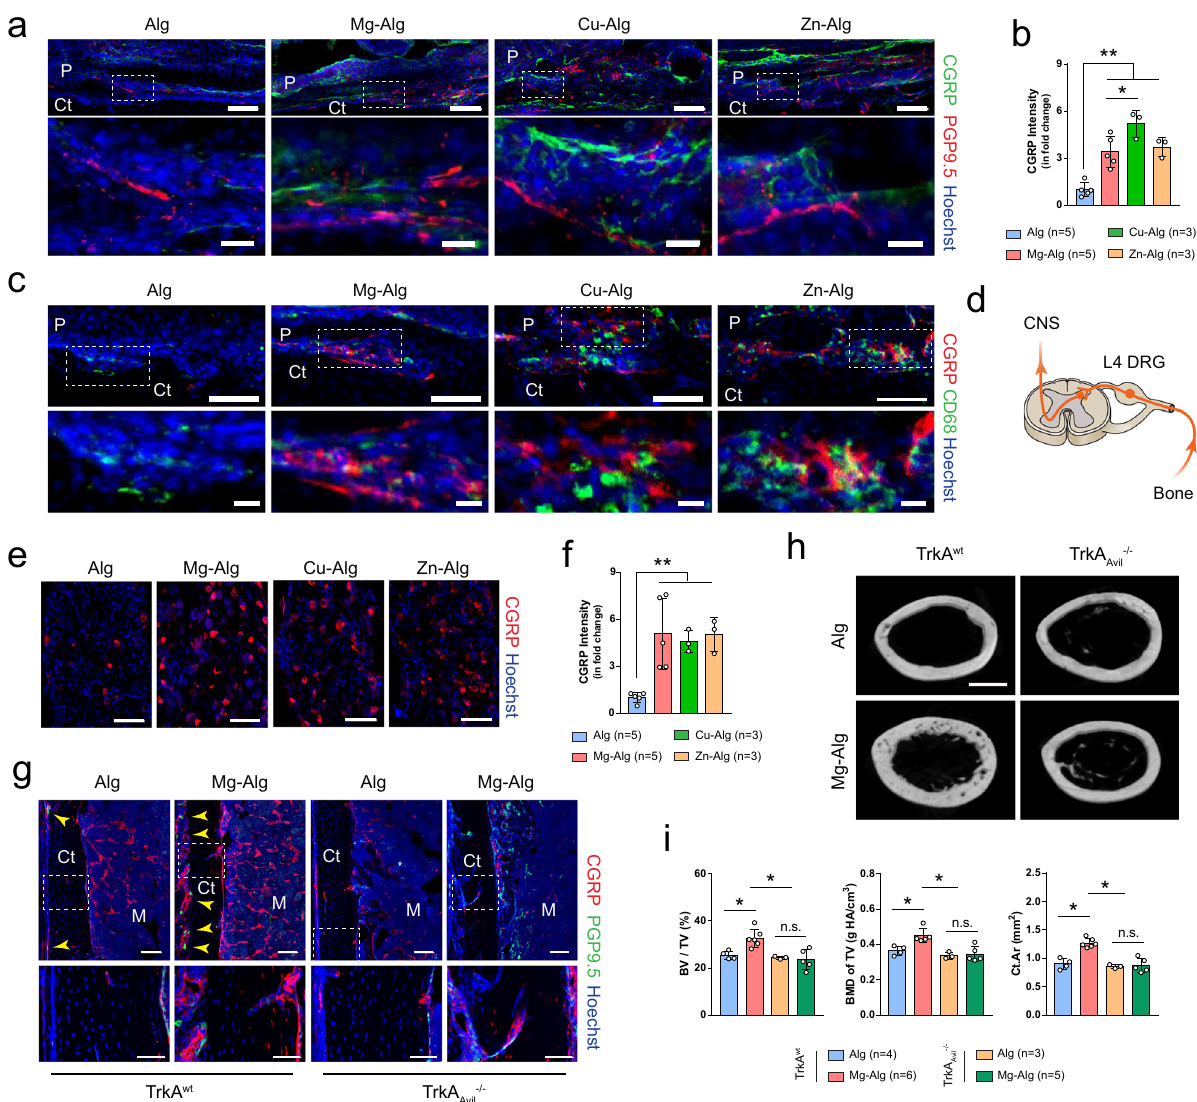
Fig. 4 Deletion of sensory nerve abolishes divalent cation-induced bone formation. a , b Representative immuno fl uorescent images and corresponding quanti fi cation showing the sprouting and arborization of calcitonin gene-related polypeptide- α + (CGRP + ) sensory nerves within the periosteum at week 1 postoperatively. Lower images (scale bars = 20 µ m) are high-resolution versions of the boxed regions in the upper images (scale bars = 100 µ m). c Co- immunostaining of CGRP with CD68 in the periosteum at week 1 postoperatively. Lower images (scale bars = 20 µ m) are high-resolution versions of the boxed regions in the upper images (scale bars = 100 µ m). DRG of L4 lumbar, which is responsible for the sensation of left femur, was harvested at week 1 postoperatively for histology study ( d ), representative immuno fl uorescent images ( e ), and corresponding quanti fi cation ( f ) showing the expression of CGRP (scale bars = 100 µ m). g Representative immuno fl uorescent images showing the presence of CGRP + sensory nerves in the femurs of TrkA wt or TrkA Avil − / − mice. Lower images (scale bars = 50 µ m) are high-resolution versions of the boxed regions in the upper images (scale bars = 100 µ m). Reconstructed µ CT images ( h , scale bars = 1 mm) showing the cross-section of femurs from TrkA wt mice or TrkA Avil − / − mice grafted with pure alginate or Mg 2 + -releasing alginate and corresponding measurements ( i ) of BV/TV, BMD of TV, and Ct.Ar. Data are mean ± s.d., * P < 0.05, ** P < 0.01 by one-way ANOVA with Tukey ’ s post hoc test. Source data are provided as a source data fi le. hydroxylase (TH) for sympathetic activity, we performed immu- examined the effect of divalent cations on the activation of skeletal nostaining of TH for sympathetic nerves. The density of TH + interoception in TrkA Avil − / − and COX2 LysM − / − mice, as well as their WT littermates. With sensory nerve denervation, the effect of sympathetic nerve fi bers on the periosteal surface of divalent Mg 2 + on phosphorylation of CREB was diminished compared cation-treated femurs was signi fi cantly less in mice injected with with their WT littermates (Fig. 5h). Daily distance and duration of divalent cation-releasing alginate compared with the controls running-wheel activity in TrkA Avil − / − mice were signi fi cantly (Fig. 5f). In parallel, spontaneous activity of mice, an indicator of longer than in their WT littermates (TrkA wt ), whereas such effect sympathetic tone and postoperative pain 26 , was assessed by spontaneous activity wheels. Compared with controls, the release of Mg 2 + on decreasing spontaneous activity was abolished in TrkA Avil − / − mice (Fig. 5i). Additionally, the increase of hypo- of Mg 2 + contributed to signi fi cantly shorter daily distance and duration, as well as lower maximum speed of running-wheel thalamic CREB phosphorylation triggered by Mg – Alg was abol- activity at weeks 1 and 4 after surgery (Fig. 5g). Finally, we ished in COX2 LysM − / − mice (Fig. 5j). Similarly, the effect of Mg 2 + NATURE COMMUNICATIONS| (2022) 13:535